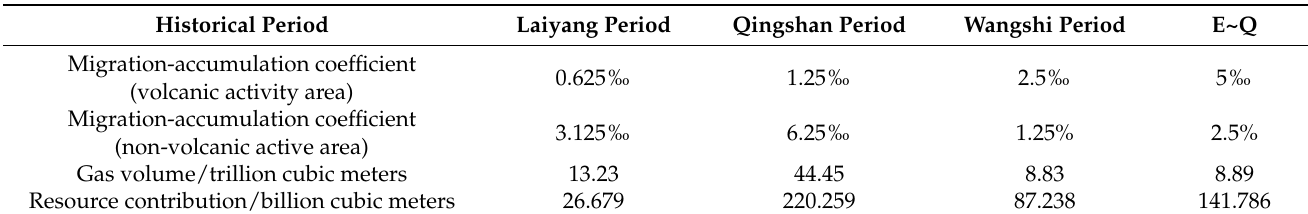
Table 2. Migration-accumulation coefficient, gas generation volume and resource contribution in different periods of the Ri-Qing-Wei